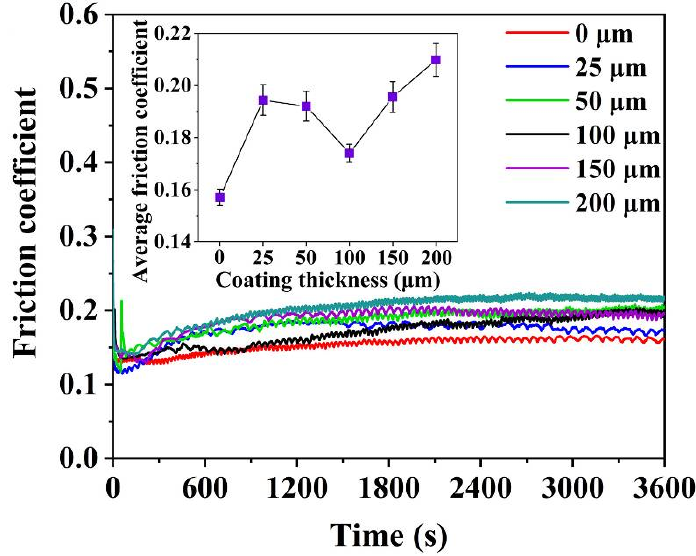
Figure 9. The COF of HVOF-PVD duplex coatings with different HVOF interlayer thicknesses. Reprinted with permission from Ref. [57]. Copyright Elsevier, 2022.